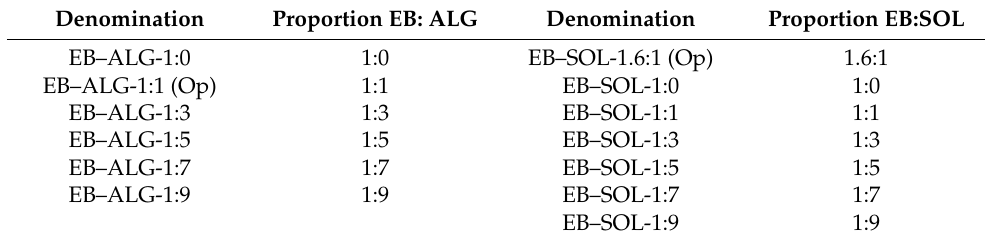
Table 7. Composition of solid dispersions of Emamectin benzoate with